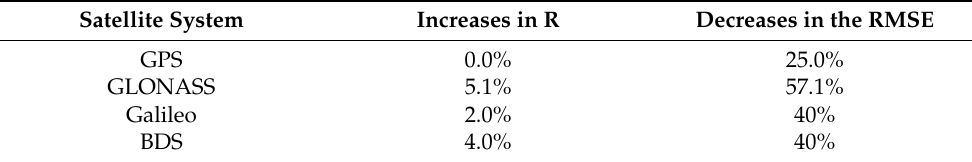
Table 5. Comparison of multi-frequency mean fusion; multi-GNSS system fusion accuracy increases in R and decreases in the RMSE.